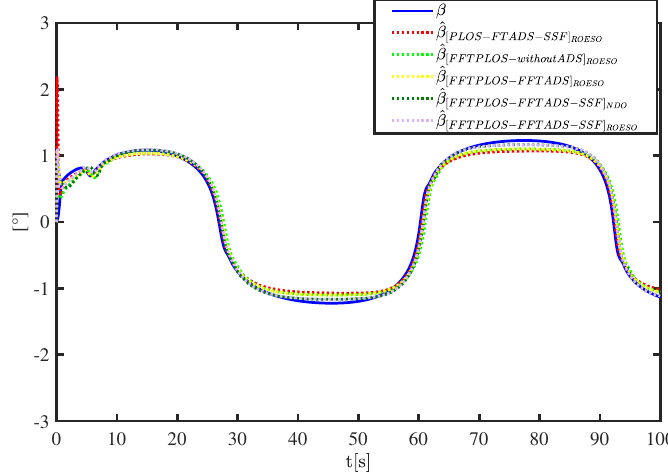
Figure 7. The time-varying sideslip angle and its